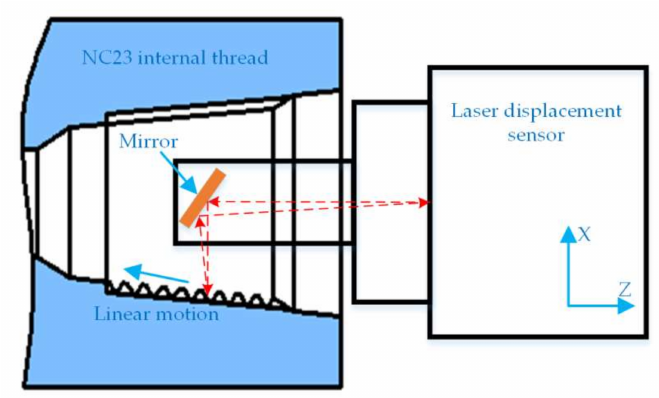
Figure 2. The principle of laser displacement sensor scanning.